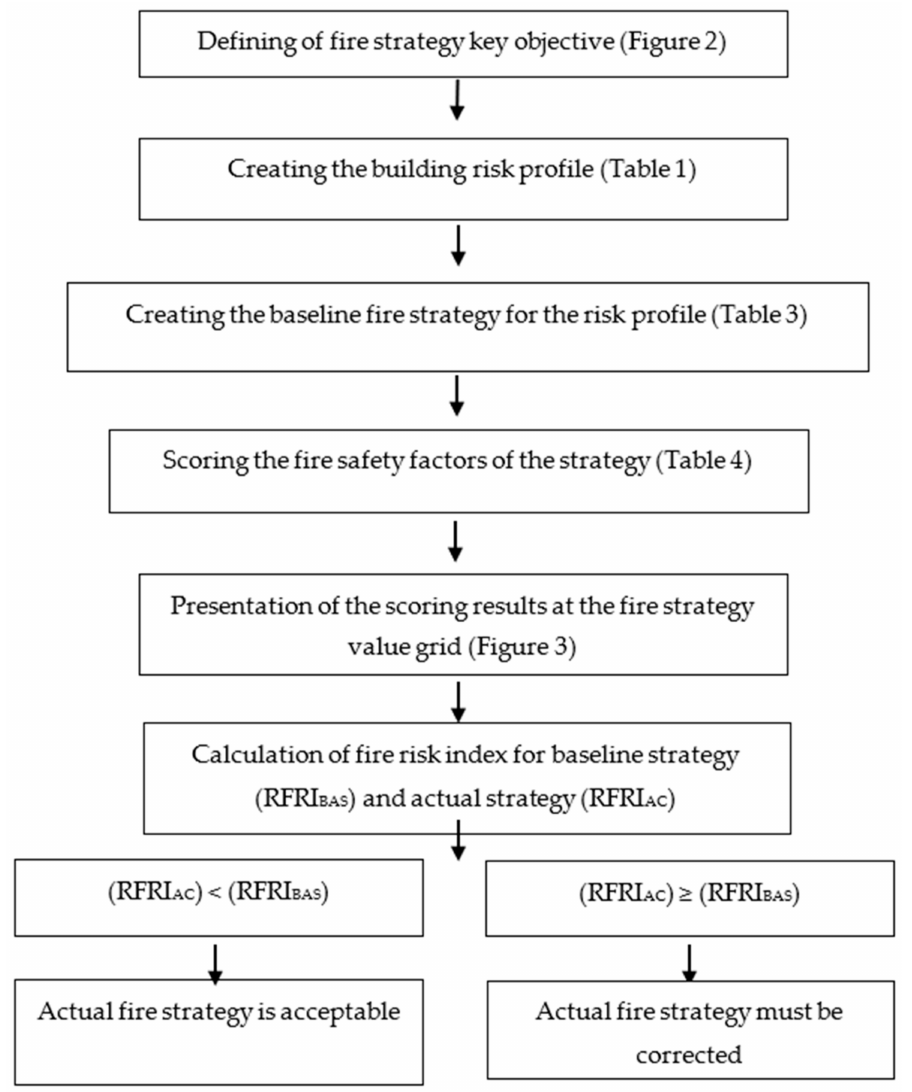
Figure 1. Fire strategy evaluation stages